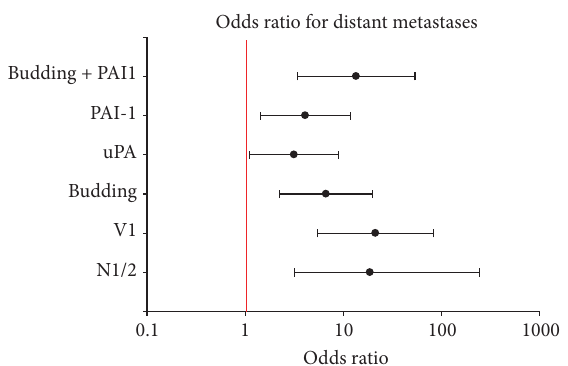
Figure 4: Pooled data: odds ratios of different risk factors for the association withdistantmetastases. Notethelogarithmicscaleof the 𝑋